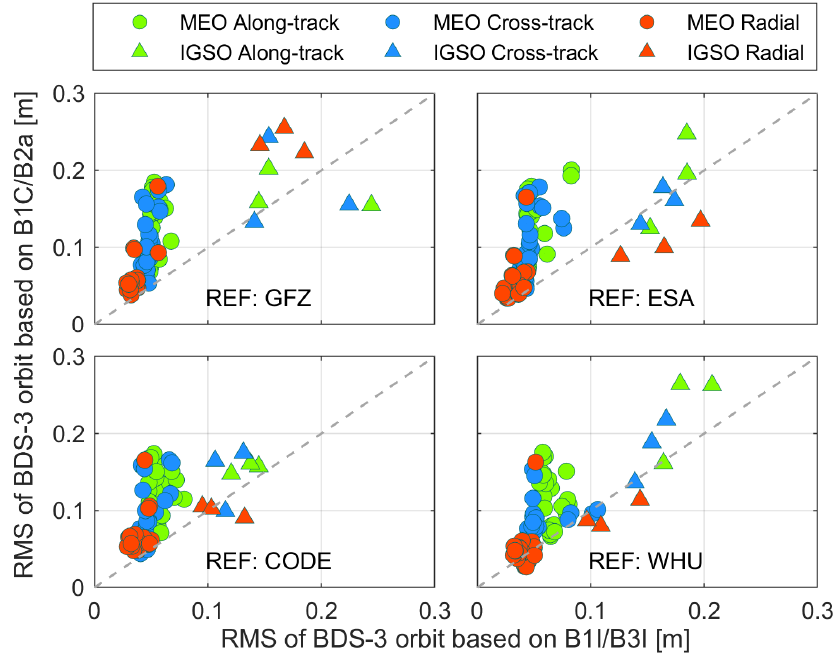
Remote Sens. 2023 , 15 , x FOR PEER REVIEW 10 of 22